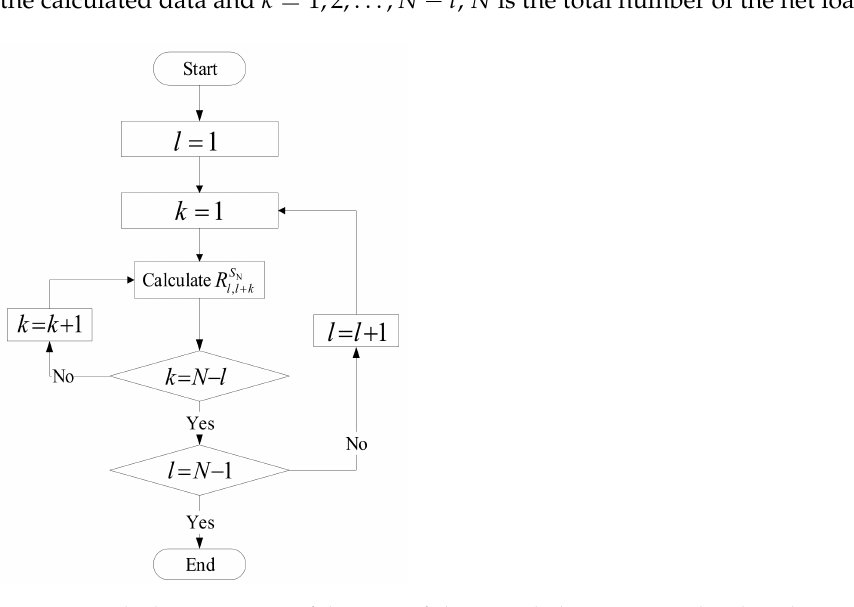
Figure 6. Calculation process of the ratio of slope symbol variation to data